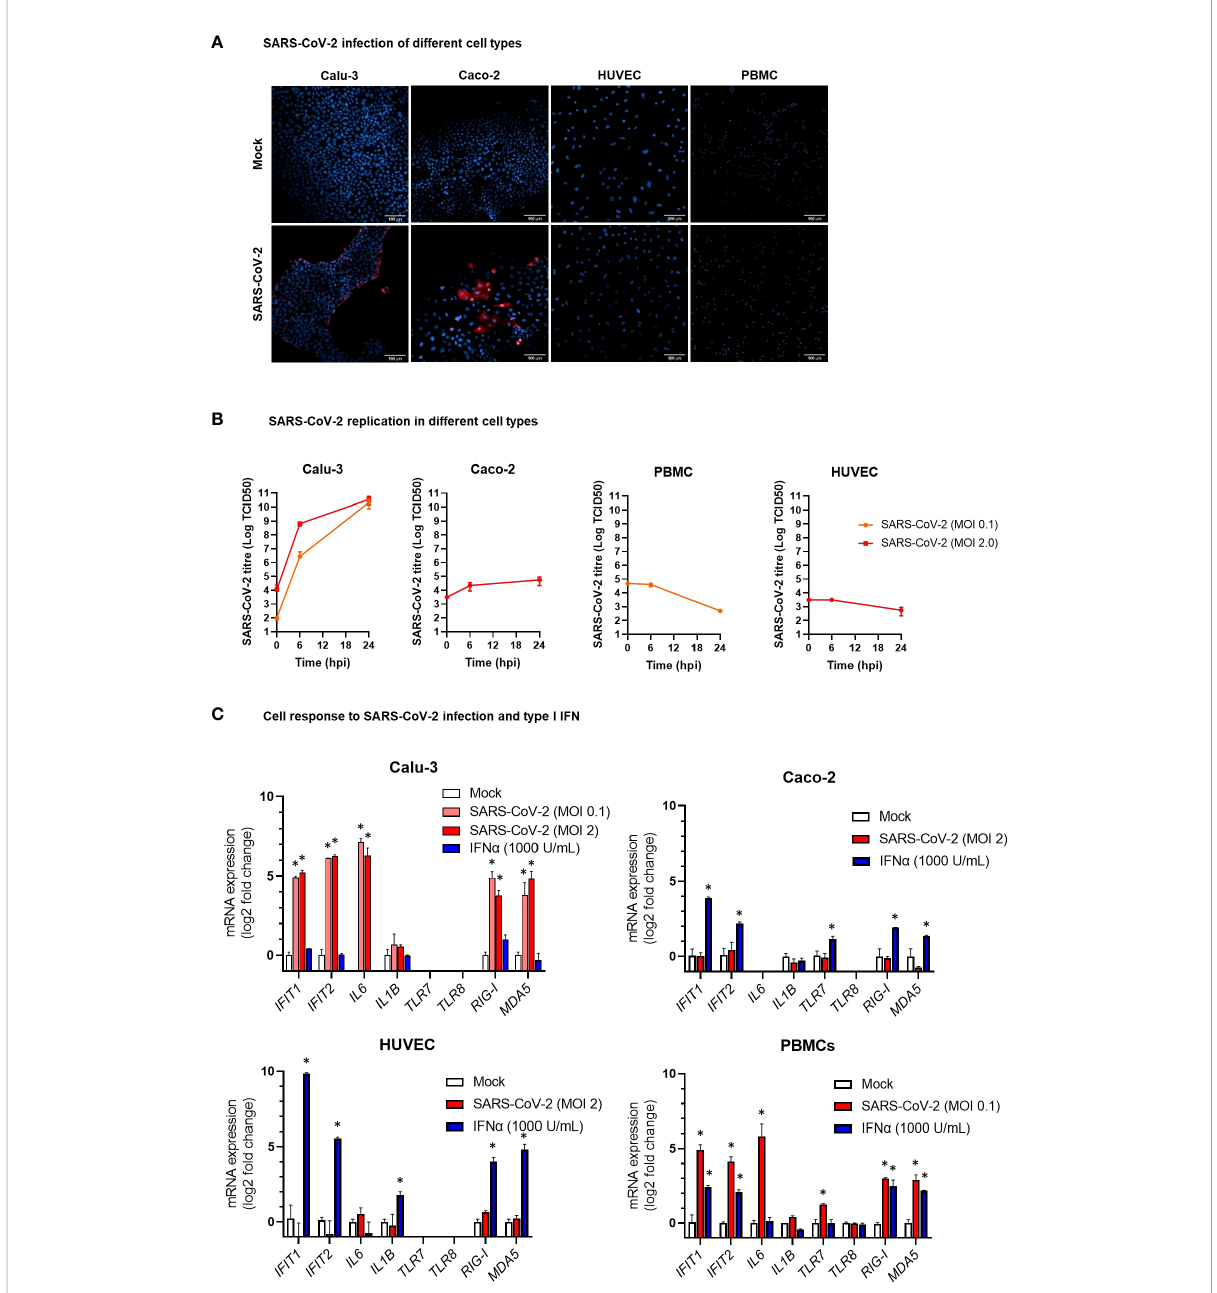
FIGURE 6 Modelling SARS-CoV-2 infection and IFN a stimulation in different human cell types. (A) Representative confocal microscopy images of lung carcinoma epithelial cells Calu-3, colon carcinoma epithelial cells Caco-2, human umbilical vein endothelial cells HUVEC, and peripheral blood mononuclear cells (PBMC) infected with SARS-CoV-2 or mock infected. Cells were stained with anti-SARS-CoV-2 nucleoprotein antibody (red) at 24 hours post infection. Nuclei were stained with draq5 (blue). 20× magni fi cation. (B) Kinetics of SARS-CoV-2 replication in Calu-3, Caco-2, HUVEC, and PBMC. Viral load was measured by TCID50 assay in cell culture supernatant collected at different hours post infection (hpi) with SARS-CoV-2 at MOI 0.1 or 2. Viral titer is represented as mean ± SD of Log TCID50 values obtained from two experiments conducted in triplicate. (C) Expression of the IFN stimulated genes IFIT1 and IFIT2 , the pro-in fl ammatory cytokine genes IL6 and IL1B , and the ssRNA sensor genes TLR7 and TLR8 in HUVEC, PBMC, Caco-2 and Calu-3 cells at 24 hpi with SARS-CoV-2 at MOI 01 or 2 or treatment with IFN- a 2b 1000 U/ mL. mRNA expression was measured by real-time RT-PCR and represented as mean ± SD of log2 fold change vs. mock (calculated with the 2 - DD CT method) obtained from two experiments conducted in triplicate. Comparison between groups (infected or treated cells vs. mock) was down by Mann-Whitney U test.